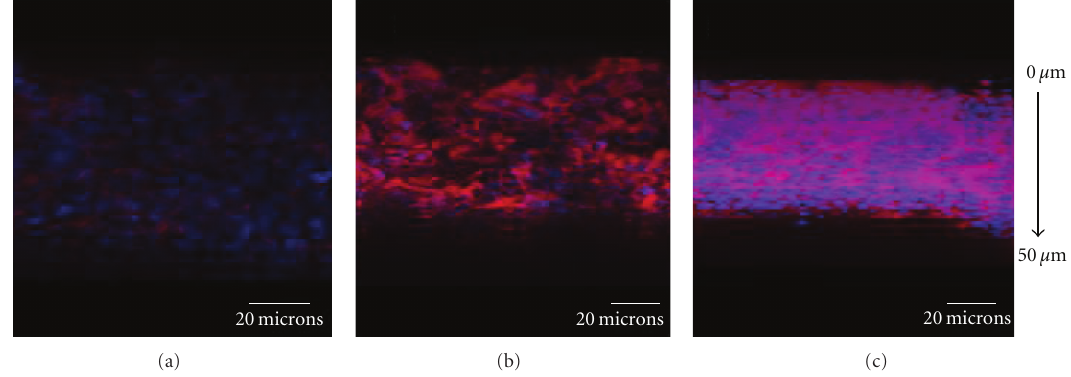
Figure 3: Multi-photon Images of Caco-2 cells treated with various molecular weight PEGs (a) Untreated cells were served as control. (b, c) Caco-2 cells were treated with PEG 3350 and PEG 8000 respectively. Cluster thickness decreased when treated with higher molecular weight PEG. The cluster thickness when treated with PEG 8000 was approximately 50 µ m. The actin filaments are shown in red and DAPI staining of nuclei is in blue. Bar length = 20 µ